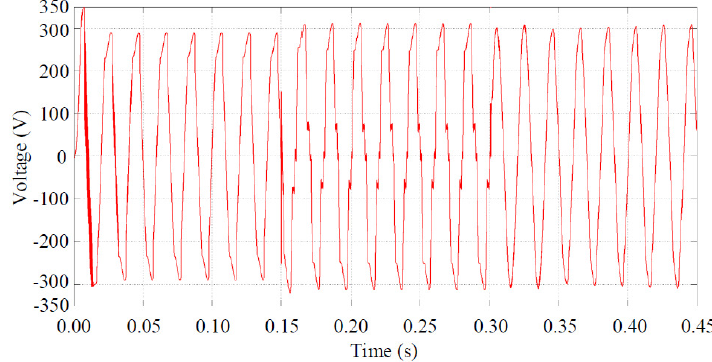
Figure 22. Phase to neutral voltage ν SA .